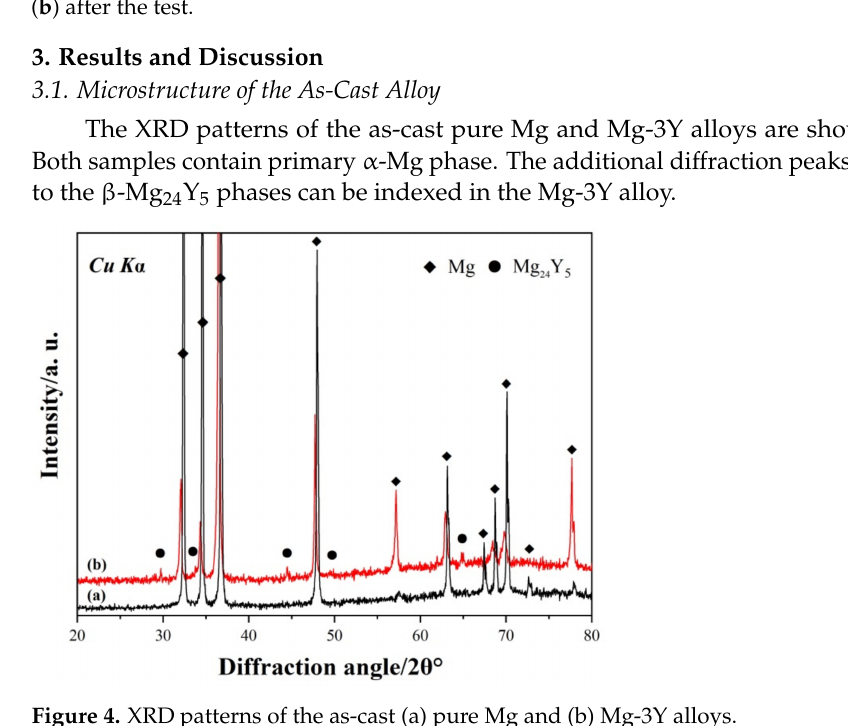
Figure 3. Schematic diagrams of the Erichsen test setup and punch position are shown ( a ) before and ( b ) after the test.